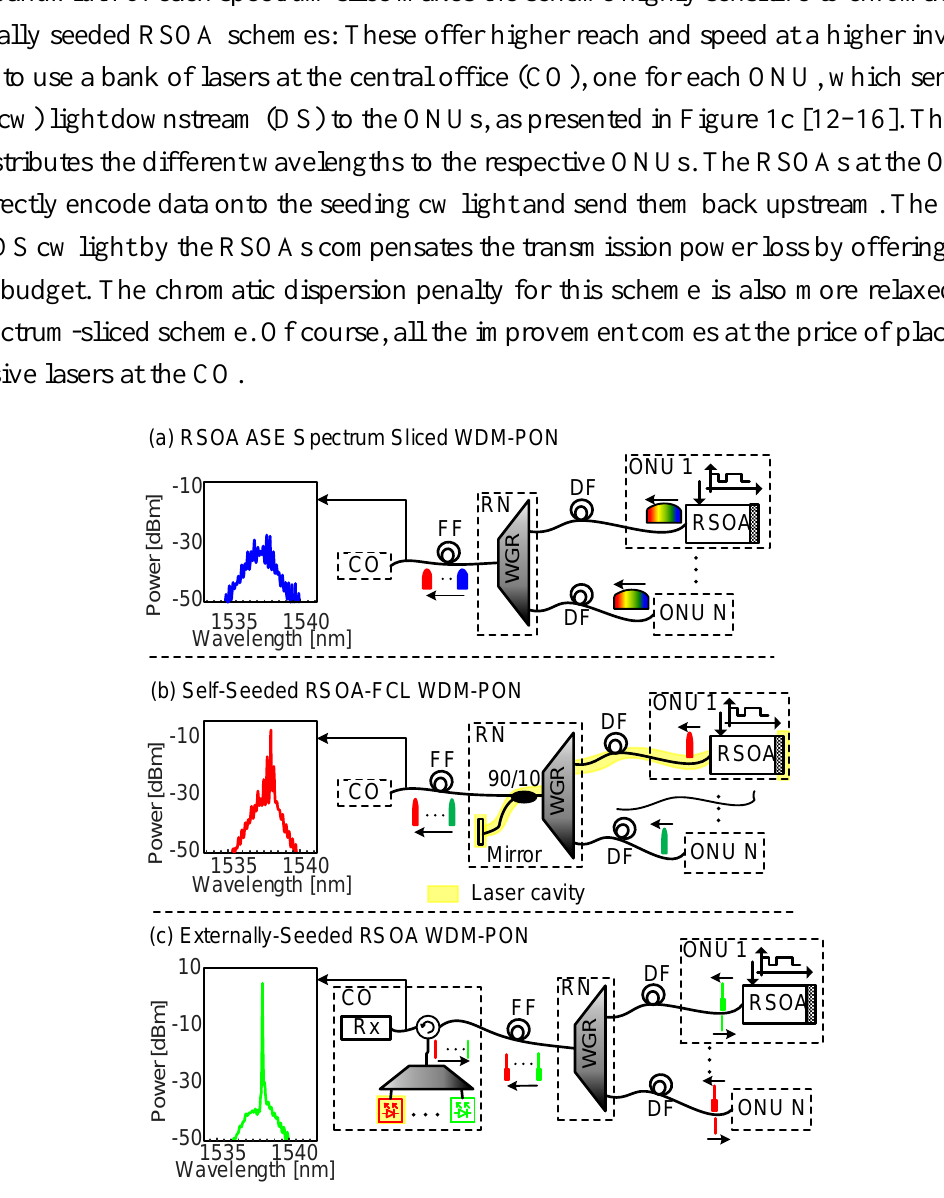
Figure 1. Scenarios showing how the three sources would be integrated in a WDM-PON. ( a ) RSOA ASE spectrum-sliced scheme: An upstream (US) signal can be directly modulated onto the ASE of the RSOAs at the optical network units (ONUs). The waveguide grating router (WGR) slices the ASE into bands and sends them upstream; ( b ) Self-seeded RSOA-FCL: A lasing resonant cavity, shown by the yellow shading, is formed between the RSOA at the ONU and a mirror at the remote node (RN). The US signal is encoded onto this multimode laser signal; ( c ) Externally seeded RSOA: A bank of lasers at the central office (CO) send cw light downstream (DS). The WGR distributes the seeding light to the respective ONUs. The RSOAs at the ONU encode data, amplify the light, and send them upstream. The corresponding measured output spectra for each scheme are plotted as insets on the left side. FF: feeder fiber, DF: distribution